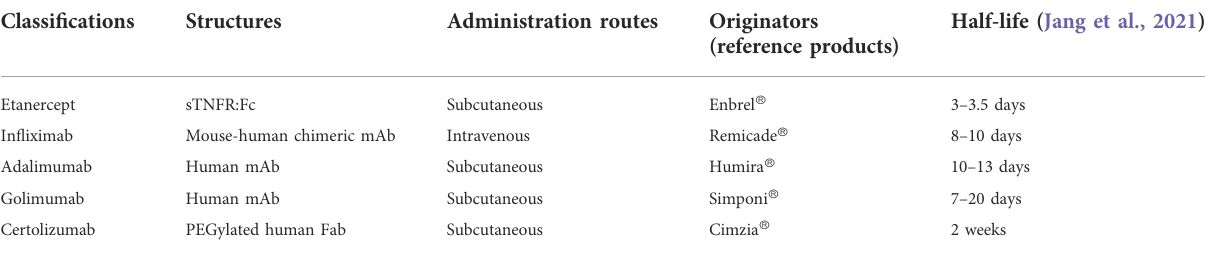
TABLE 2 The drug-related attributes of anti-TNF- α